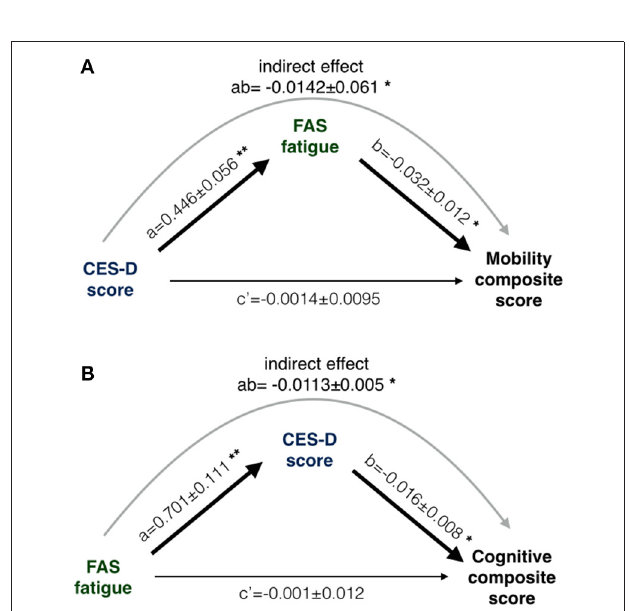
FIGURE 4 | The results of two mediation path analysis models. One path model (A) was designed to explain between-subjects differences in mobility; the other path model (B) attempted to explain between-subjects cognitive differences. Coefficients in the path model are listed as a, b and c’, where a and b are part of the indirect path and c’ is the direct path adjusted for the indirect path. (A) CES-D was not directly associated with mobility (c’ non-significant) but the indirect path was significant (denoted as ab). (B) FAS was not directly associated with cognition (c’ non-significant) but the indirect path was significant (denoted as ab). Statistical criteria for significance are * p < 0.05 and ** p <